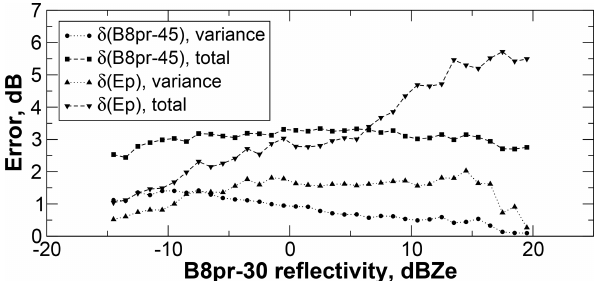
Figure 5. Errors in reflectivity for the Ep and B8pr-45 shapes com- pared to the B8pr-30 shape. Errors shown are total (bias + variance) and variance